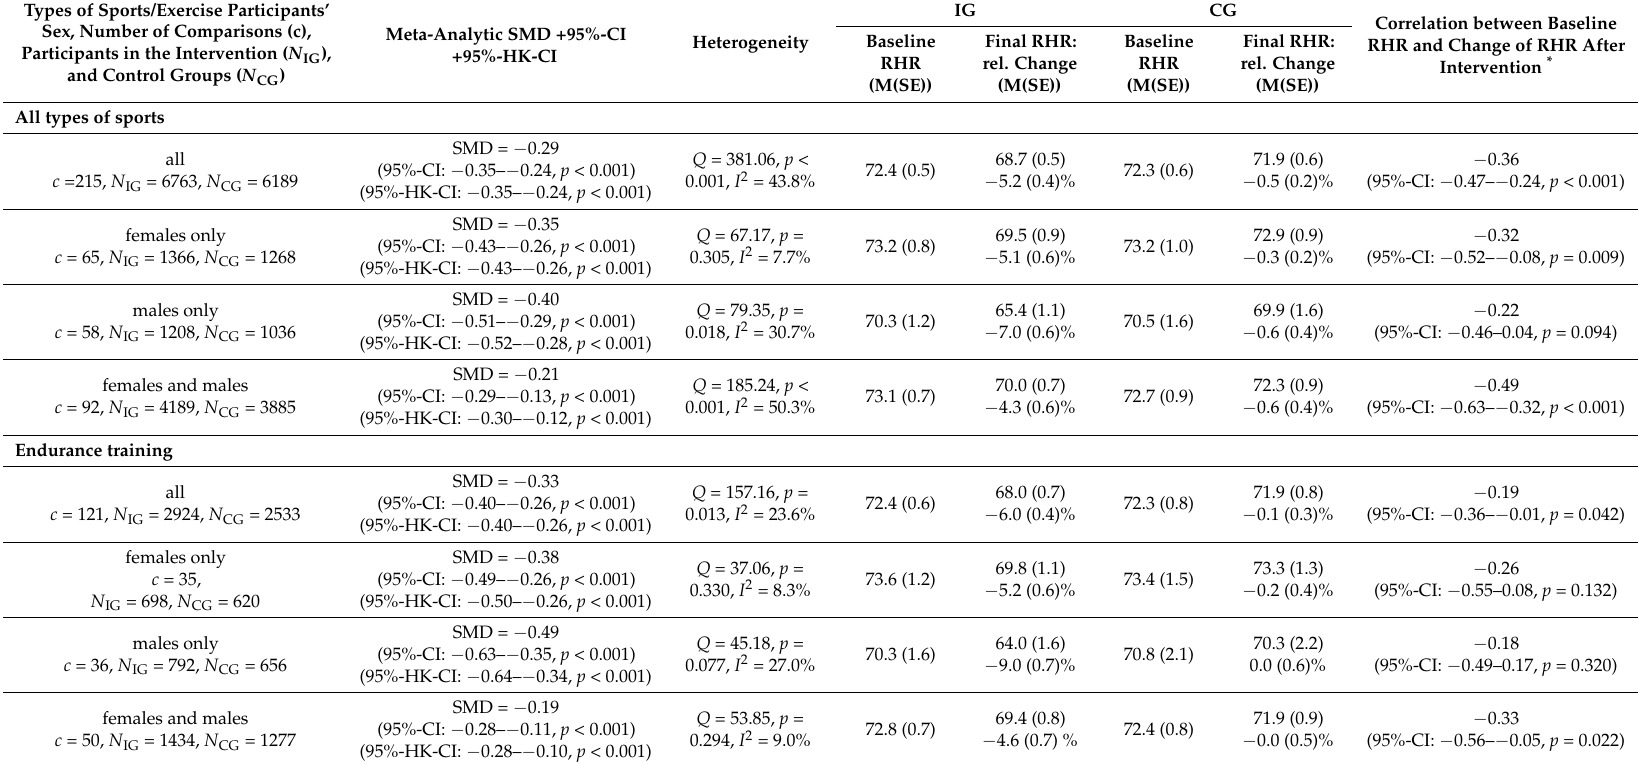
Table 2. Effects of regular exercise/sports on RHR according to type of